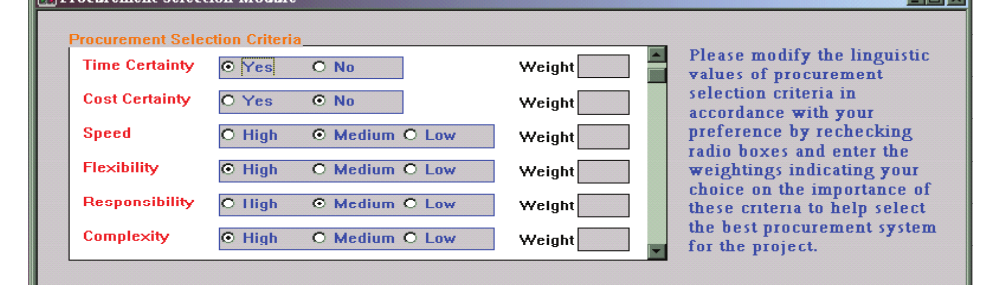
Figure 8: Interface for altering the PSPs and weightings at procurement selection stage